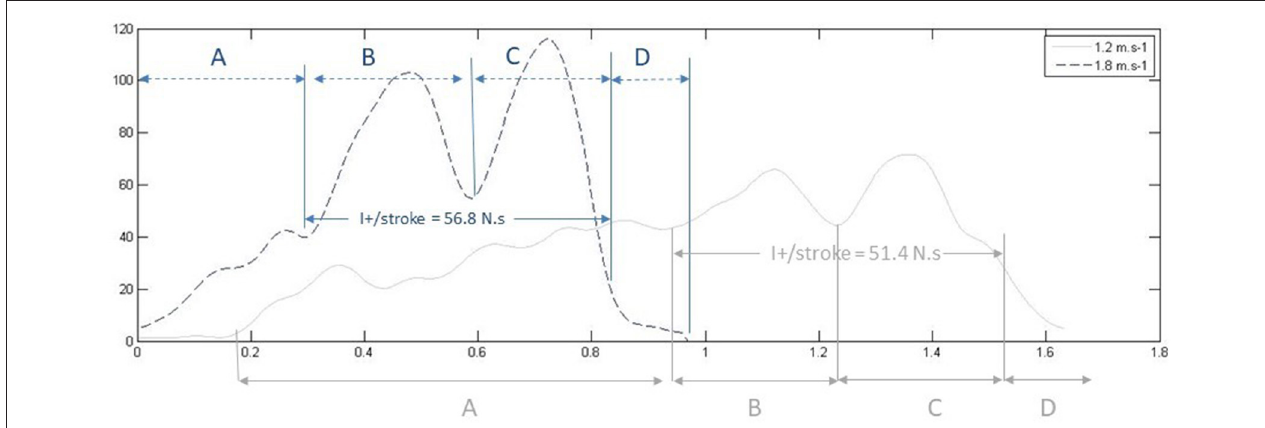
FIGURE 2 | Example force time series from a national level swimmer at two different paces (V1 = 1.2m.s − 1 , 70% vs. V4 = 1.8m.s − 1 , 100%), and the corresponding duration of the swim phases for each pace. The graph illustrates how two cycles can have comparable overall impulses (I + /stroke) whereas Fpull and Fpush are of higher magnitude at V4 compared to